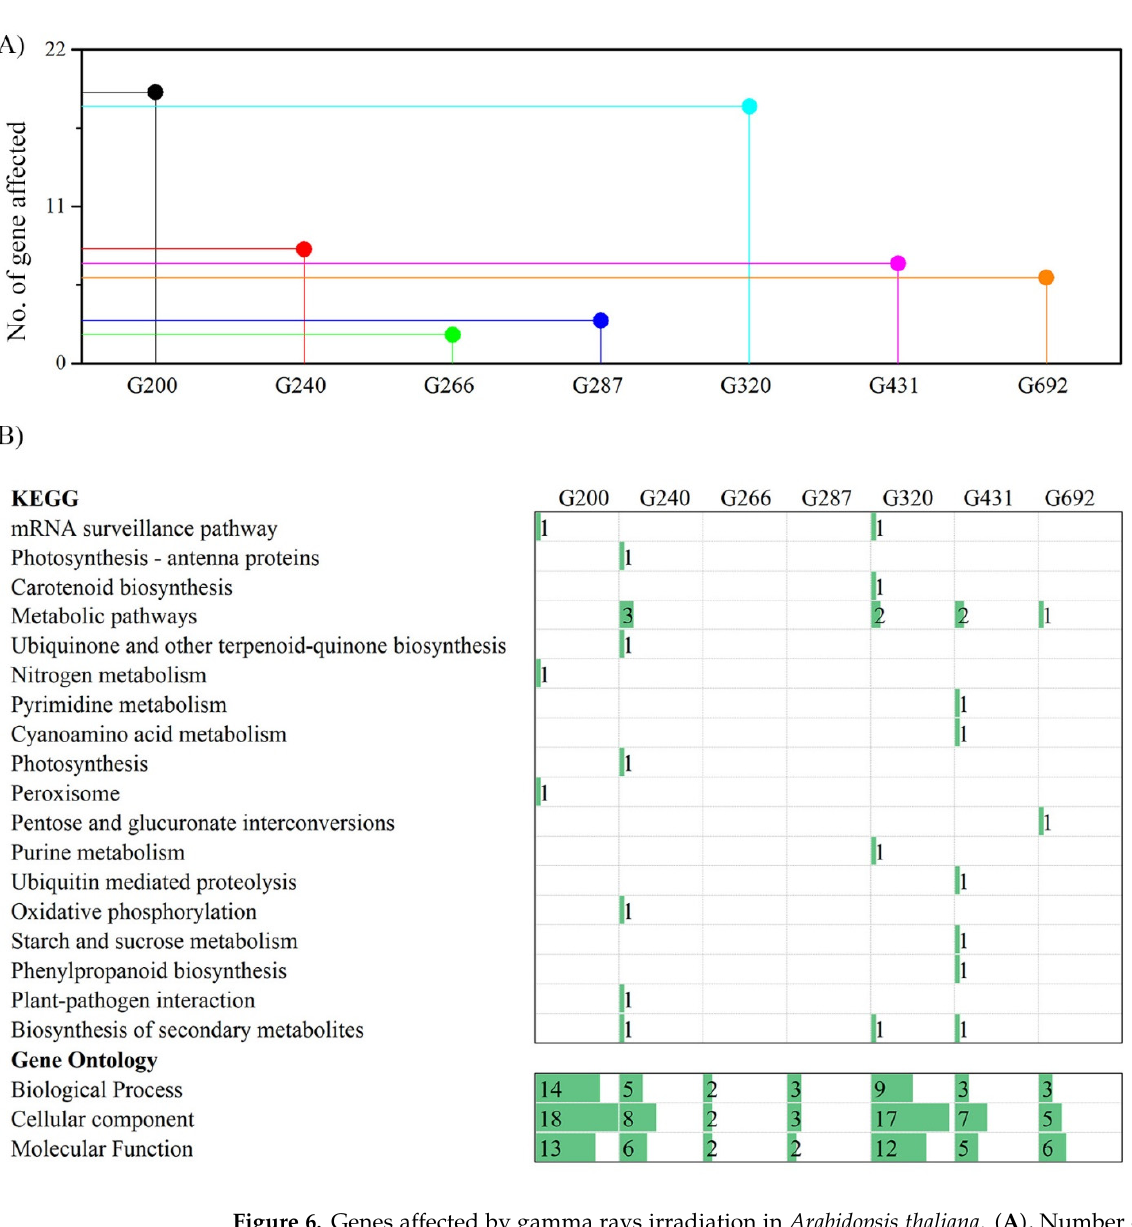
Figure 6. Genes affected by gamma rays irradiation in Arabidopsis thaliana . ( A ), Number of genes affected in each line. ( B ) KEGG pathway and GO analysis of affected genes.